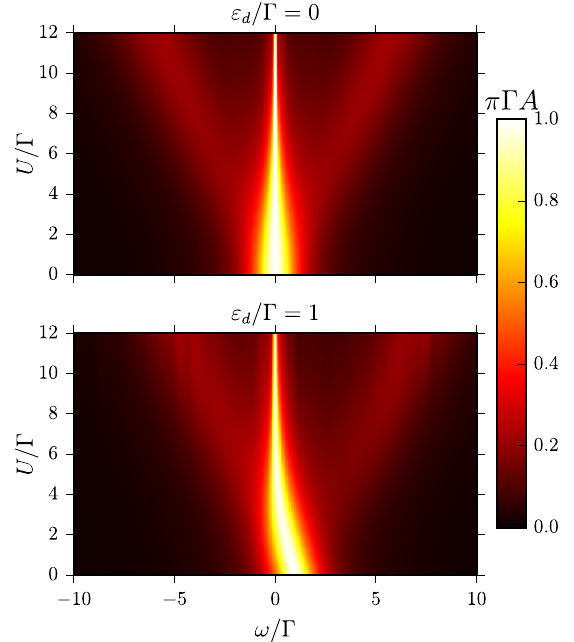
FIG. 12. Color plot of the spectral density A ð ω ; U Þ in the = Γ ¼ 0 , upper) and asymmetric case symmetric case ( ϵ d = Γ ¼ 1 , lower) as a function of ω and U . The data from ( ϵ d each panel are obtained in a single QMC run.